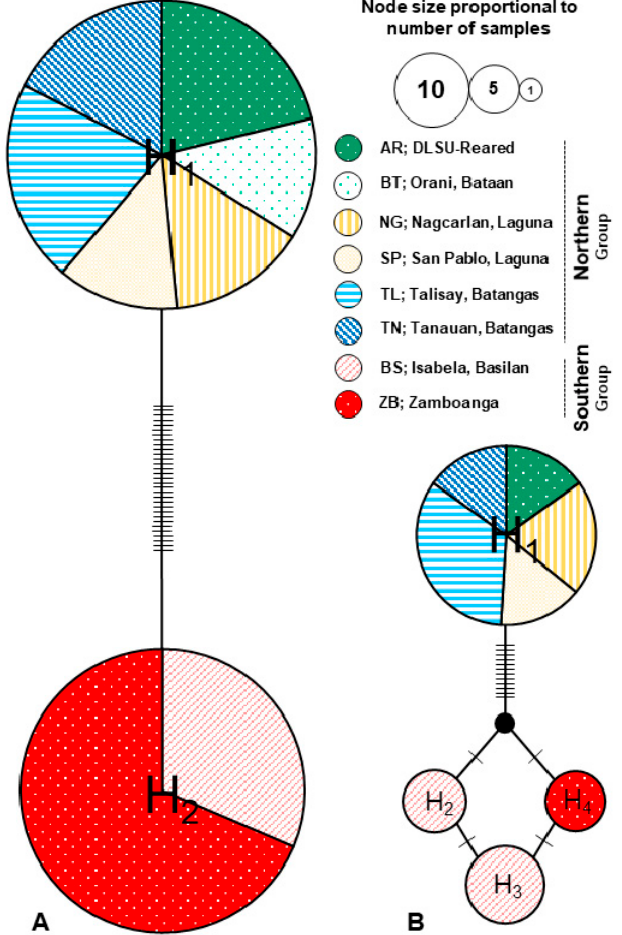
Figure 3. Median-joining network of the A. rigidus populations from 305 individuals for the mtCOI gene ( A ), and 75 individuals for the protein-coding EF-1 α gene ( B ), showing location and frequency of haplotypes. Each circle represents an observed haplotype; circle size indicates the number of individuals observed; the colors correspond to sampling localities. The total number of mutations, Eta presented as hatch marks.